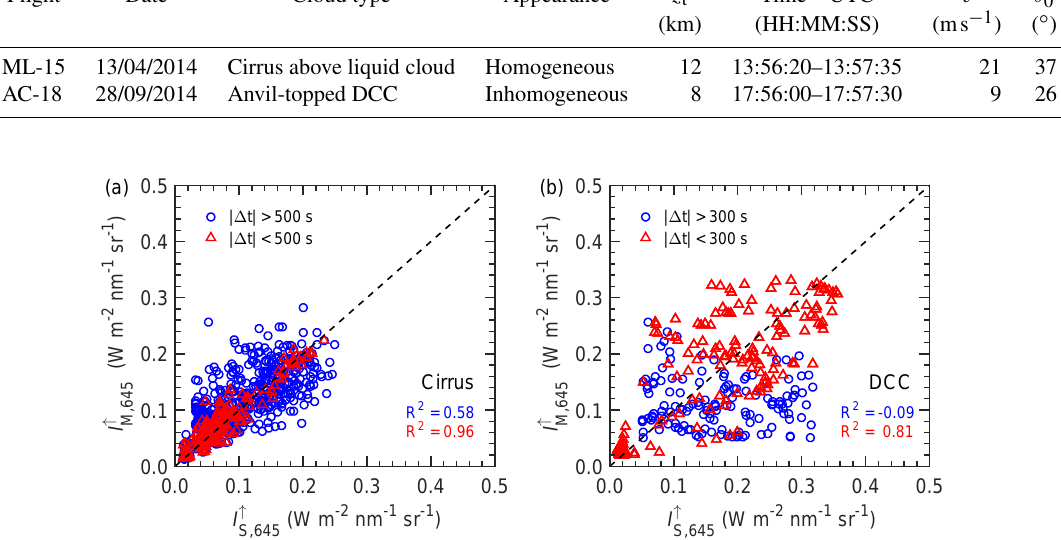
↑ ↑ ) and MODIS ( I ) within a threshold of 500s S , 645 M , 645